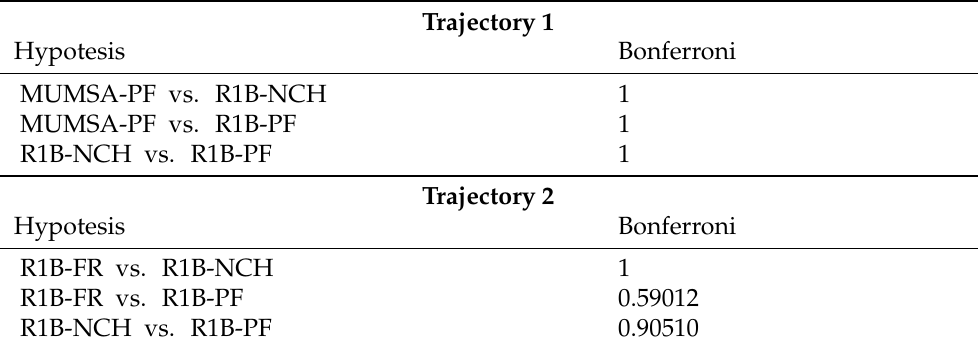
Table 10. p -values for tests in the multiple comparisons among the three outstanding algorithms in study case 1 using both trajectories. All algorithms draw two times in both trajectories.